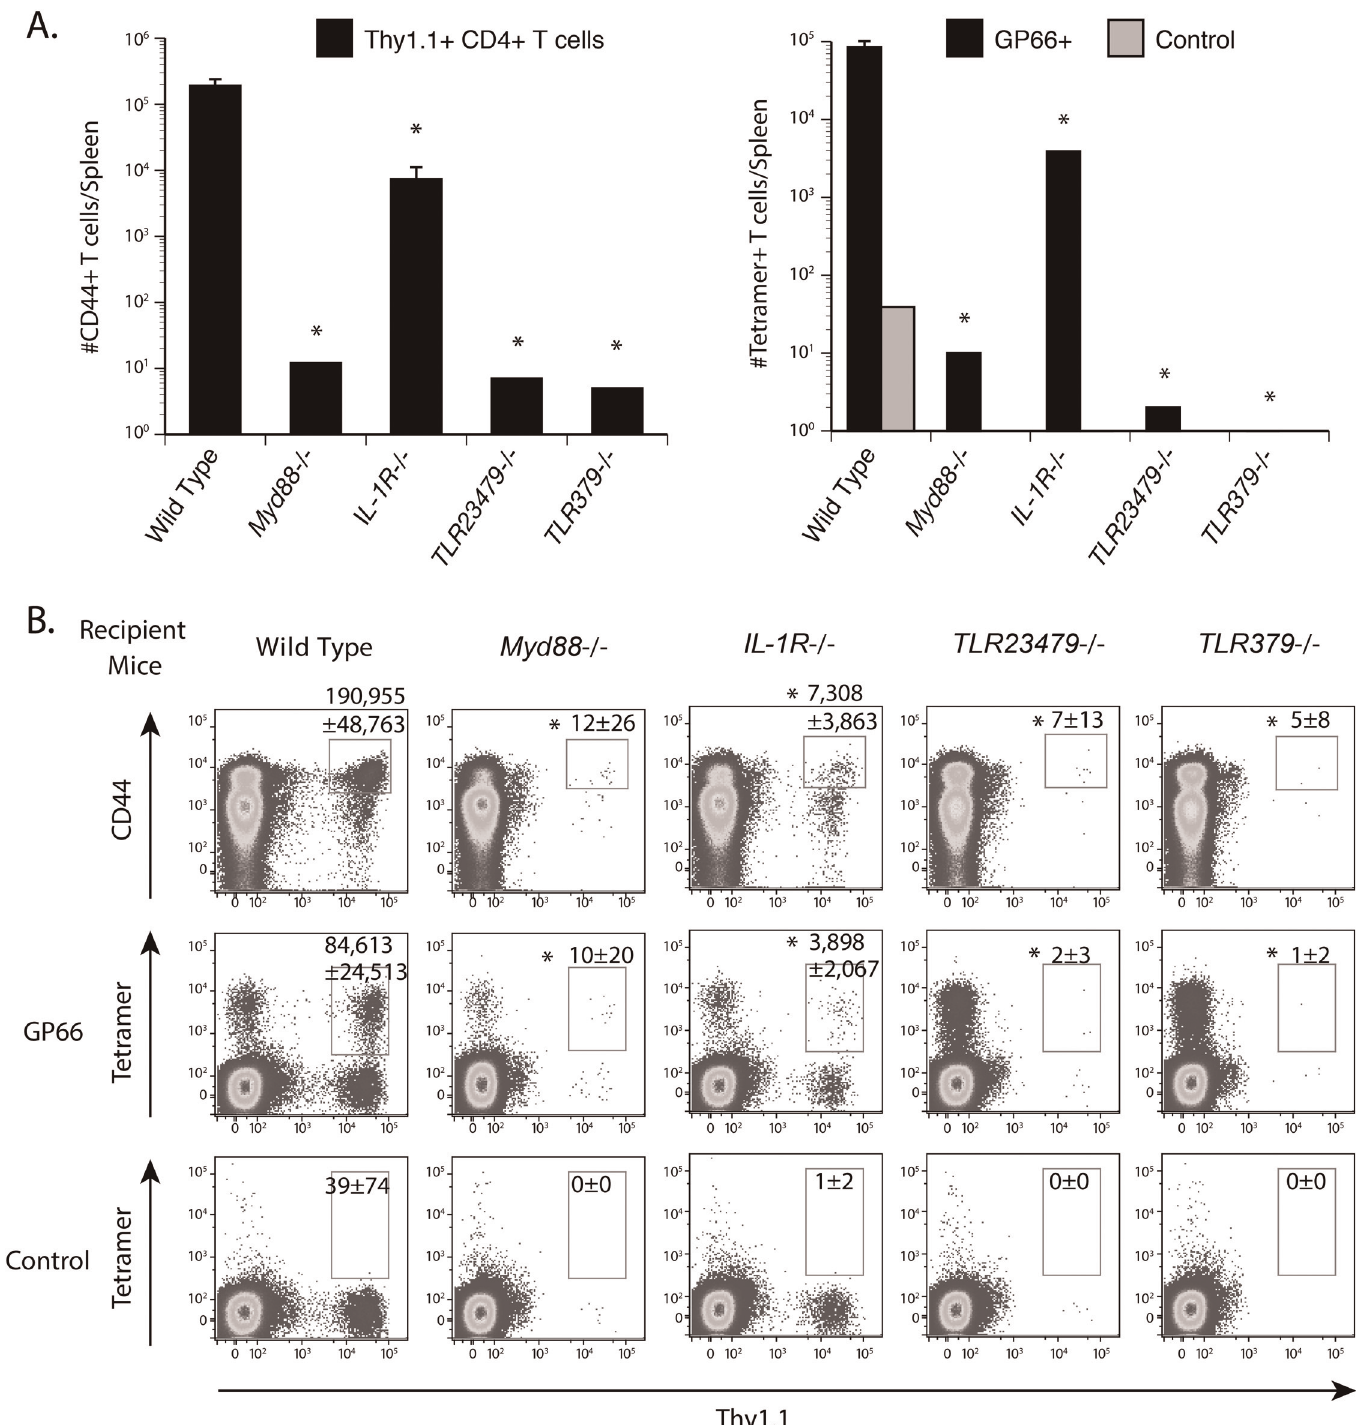
Fig 7. TLR379 upstream of MyD88 extrinsically regulate contraction of LCMV primed CD4 + T cells. Congenic Thy 1.1 + wild type mice were infected with 2 x 10 5 pfu of LCMV Armstrong. At day 8 post-infection, CD4 + T cells were purified from the spleen and adoptively transferred into na ï ve Myd88 -/- , IL- 1R -/- , TLR23479 -/- , TLR379 -/- , TLR24 -/- and wild type mice. After 4 weeks of rest, tetramer-positive, gp66-specific CD4 + T cells were enumerated in the spleen. (A, B) The numbers represent the geometric mean ± SEM of tetramer-positive cells from 5 mice. Data are expressed from a single experiment representative of two independent experiments. * P < 0.05 vs. vaccinated wild type control